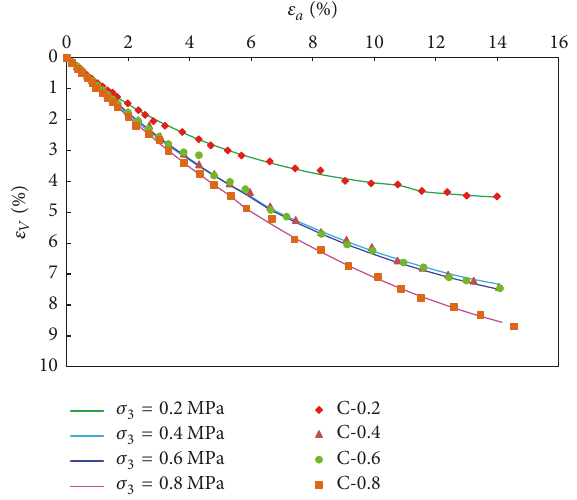
Figure 12: Measured and calculated 𝜀 V values.